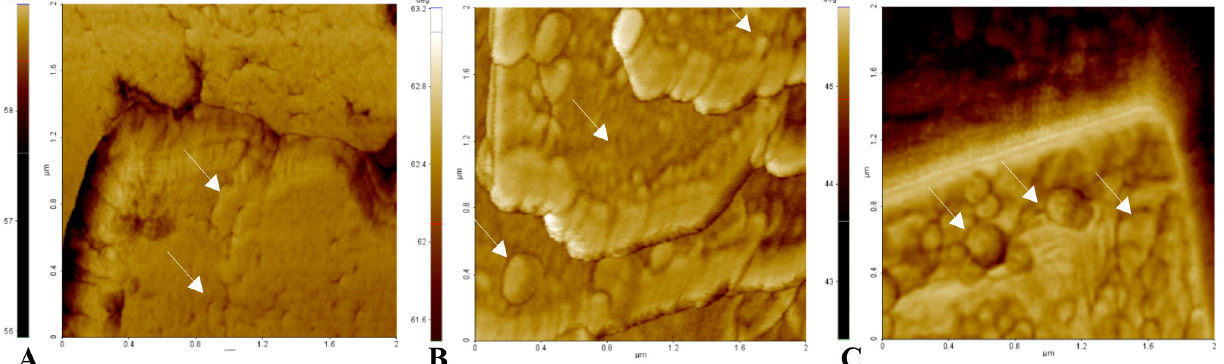
Fig 11. Surface pattern of three phase images by AFM. The figure shows the probable effects of AE component(s) on the CaOx crystal surface. In contrast to control sample (A), in the presence of 50 μ g dw/ml C . officinarum AE (B) small globular shapes are present increasing in size in the presence of 1000 μ g dw/ml C . officinarum AE